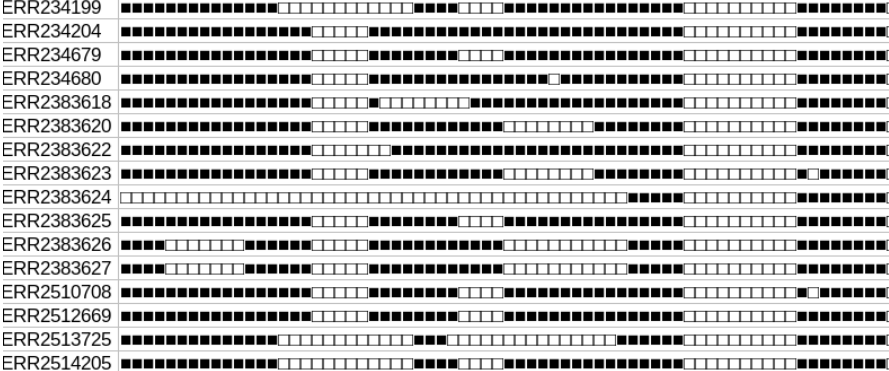
Figure 1. Example of spoligotypes of Lineage 5, defined by their accession